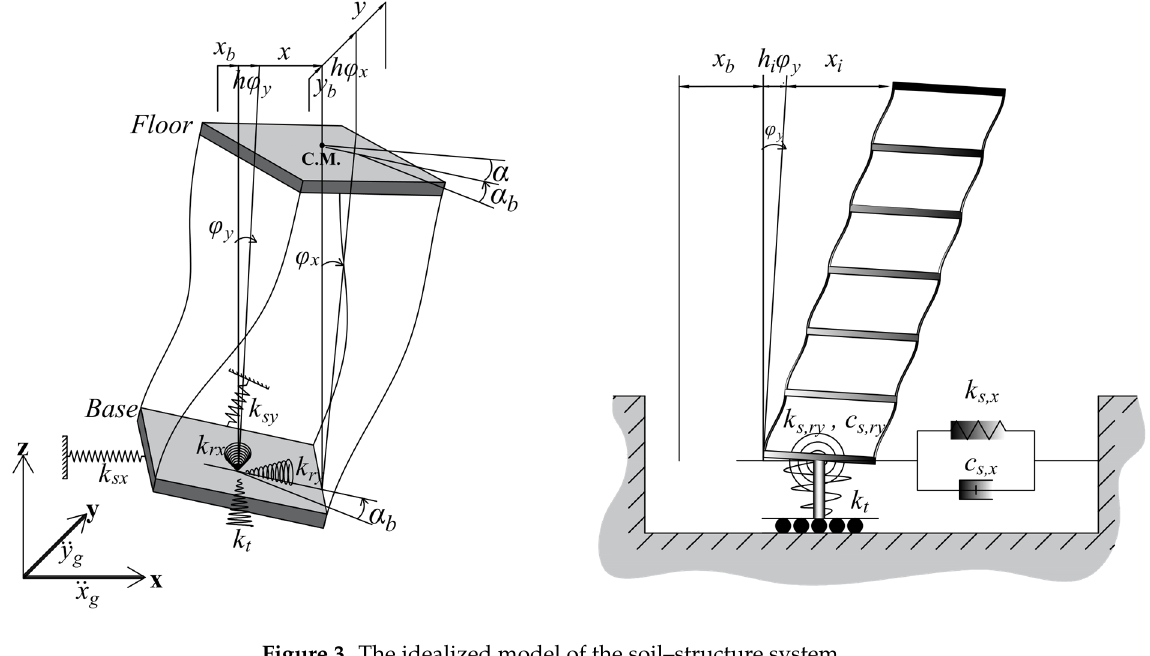
Figure 3. The idealized model of the soil–structure system.